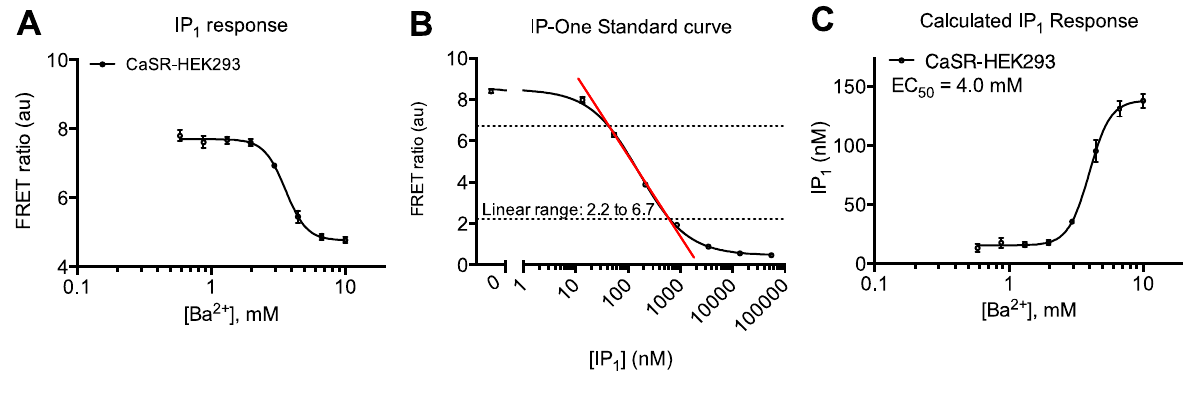
pathway activation in CaSR-HEK293 Figure 5. Characterization of barium-induced G q cells using HTRF ® based assay. ( A ) Concentration-response curve of barium in the IP-One assay using 10 4 cells/well and stimulation for 1 h at 37 °C. Decrease in FRET signal is inversely proportional to IP accumulation; ( B ) IP-One standard curve showing 1 concentration-response curve of the IP-One Calibrator diluted in a 1:1 mixture of Ligand and Assay buffer; ( C ) Concentration-response curve of barium from ( A ) showing the amount calculated by use of the standard curve in ( B ). Data are mean ± S.D. of of accumulated IP 1 triplicate determinations and representative for three independent